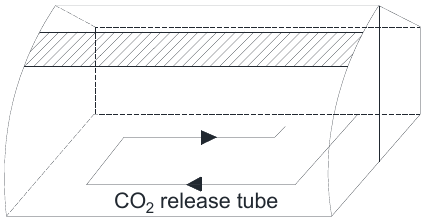
Figure 7. Chinese solar greenhouse model used in the study of Fang et al. [58], with a roof opening only.